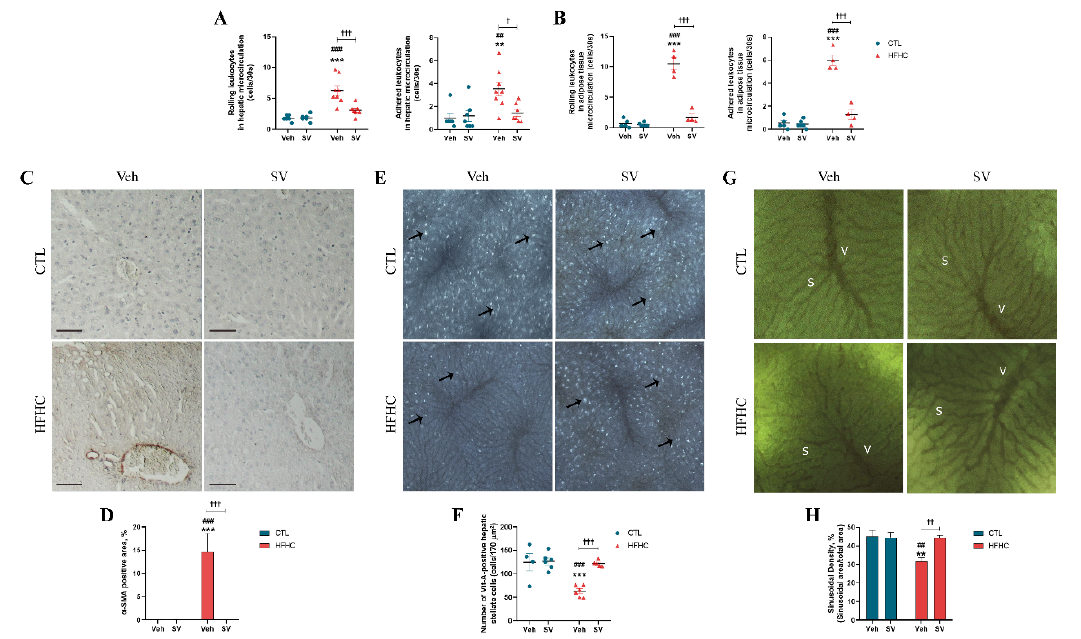
Figure 3. SV prevents microcirculatory dysfunction in HFHC-fed mice. Liver ( A ) and adipose tissue ( B ) microcirculation assessed via intravital microscopy following intravenous administering of rho- damine 6G with quantification of adhesion and rolling of leukocytes. Representative immunohisto- chemical staining of liver sections showing expression of alpha smooth muscle actin (α-SMA) in mice fed with control diet (CTL+Veh), control diet plus SV (CTL+SV), HFHC diet (HFHC+Veh), or HFHC plus SV treatment (HFHC+SV) ( C ). Quantification of the percentage of α-SMA-positive area is represented in ( D ). In vivo distribution ( E ) and quantification ( F ) of vitamin A-positive cells in- dicative of retinoid storage in cytoplasmic droplets of hepatic stellate cells. Representative intravital fluorescence microscopic images ( G ) and quantification ( H ) of sinusoidal perfusion density in the liver following intravenous administering of fluorescein isothiocyanate-labeled dextran. ** p < 0.01 vs. CTL+Veh; *** p < 0.001 vs. CTL+Veh; ## p < 0.01 CTL+SV; ### p < 0.001 vs. CTL+SV; † p < 0.05 HFHC+SV; †† p < 0.01 HFHC+SV; ††† p < 0.001 HFHC+SV.